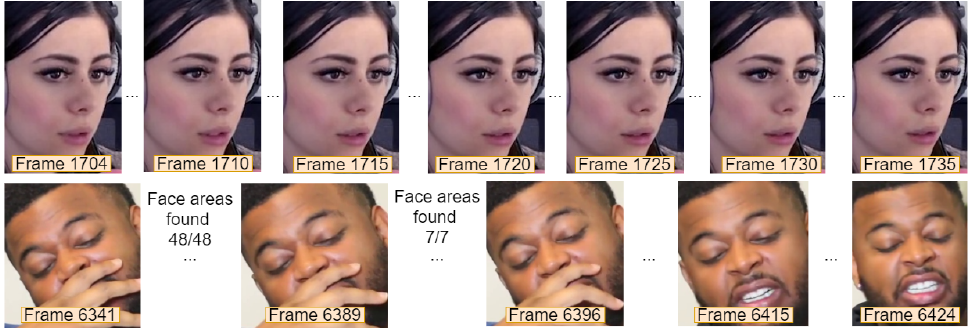
Figure 5. The face detection results on the same two video sequences presented in Figure 4 using